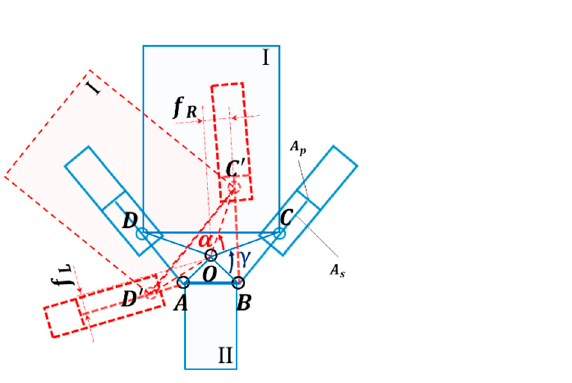
Figure A1. Steering joint kinematics: straight line (blue), turning (red).